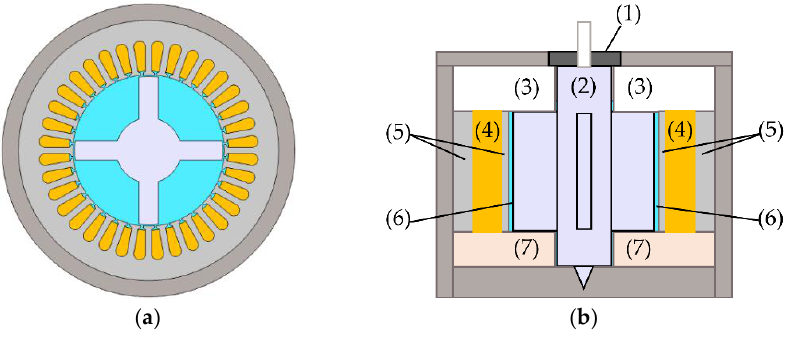
Figure 1. The experimental motor model; ( a ) top, ( b ) side view. Here: (1) bearing, (2) nonmagnetic rotor, (3) air, (4) coil set, (5) iron cores, (6) magnetic fluid, (7) clay.